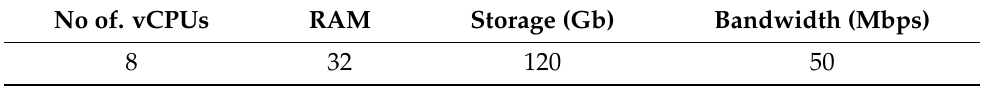
Table 2. CYRA’s hardware